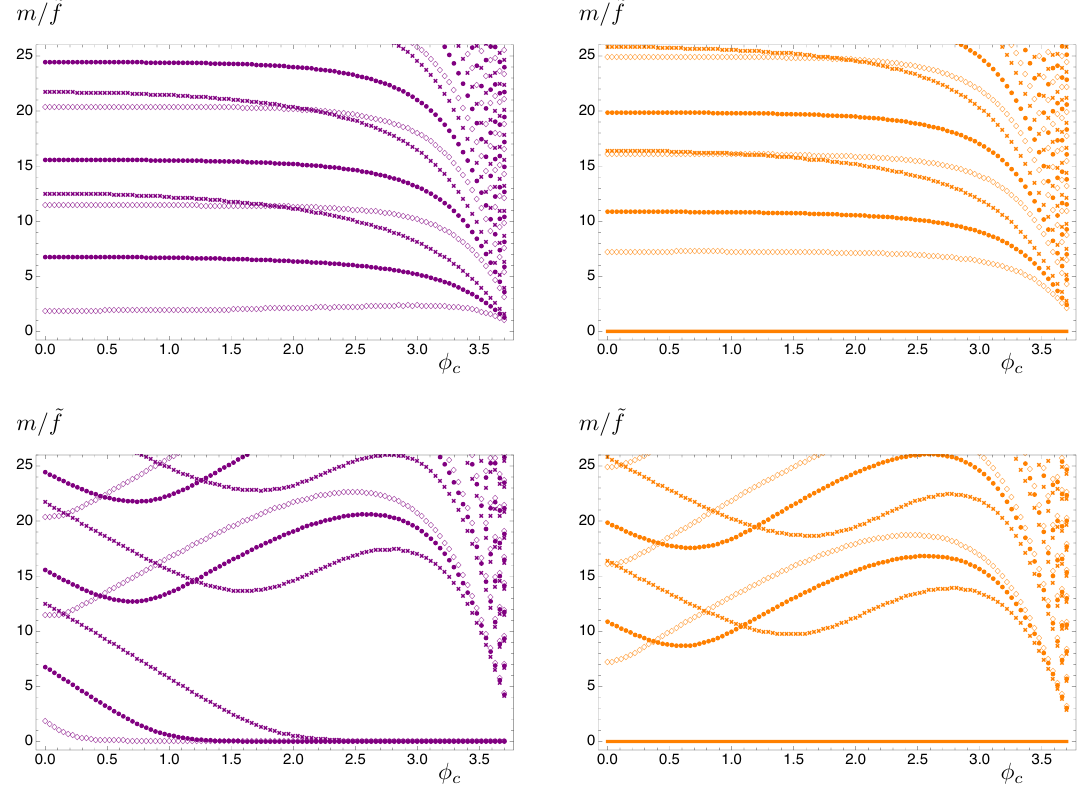
Figure 6 . Model II. Fermionic spectrum as a function of φ c for ∆ R = 1 . 6 , 2 . 5 , 4 (diamonds, dots, crosses), ∆ = 3 , x F = 1 , g 5 = 8 , ∆ φ = 0 . 2 , r 1 = 10 − 12 , r 2 = 15 , and y 5 = 0 , − 2 (top, bottom p panels). The maximum allowed value of φ c is given by 3 / ∆ φ ≈ 3 . 87 . The left and right